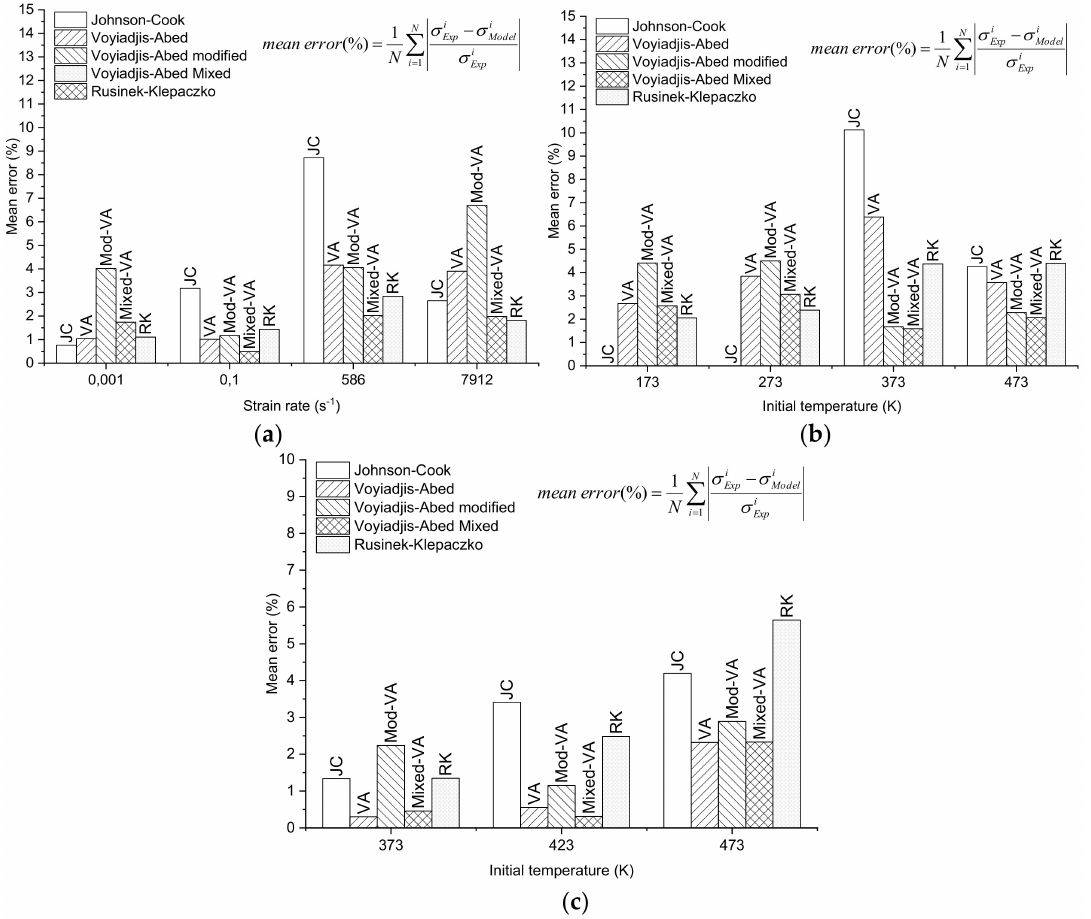
Figure 18. Comparison of mean error: ( a ) for different strain rates, at T 0 =293 K; ( b ) for different temperatures, at ~1100 s − 1 and ( c ) for different temperatures, at ˙ ε = 0.001 s − 1